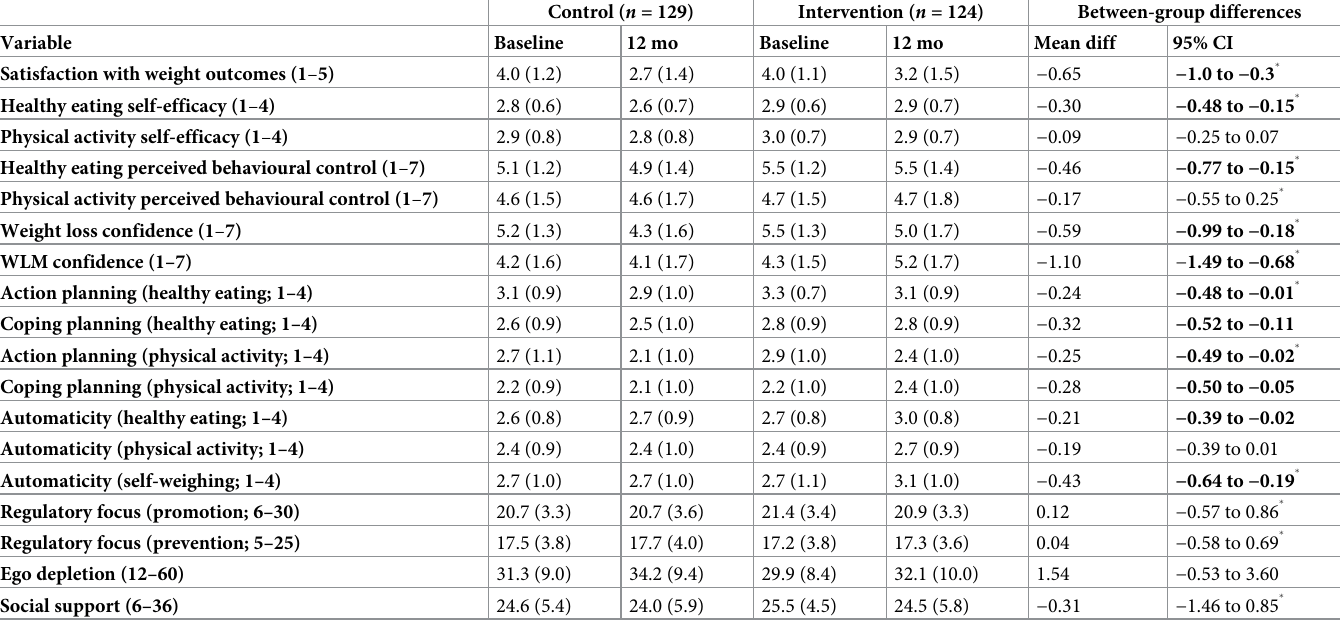
Table 3. Psychological variables at baseline and 12